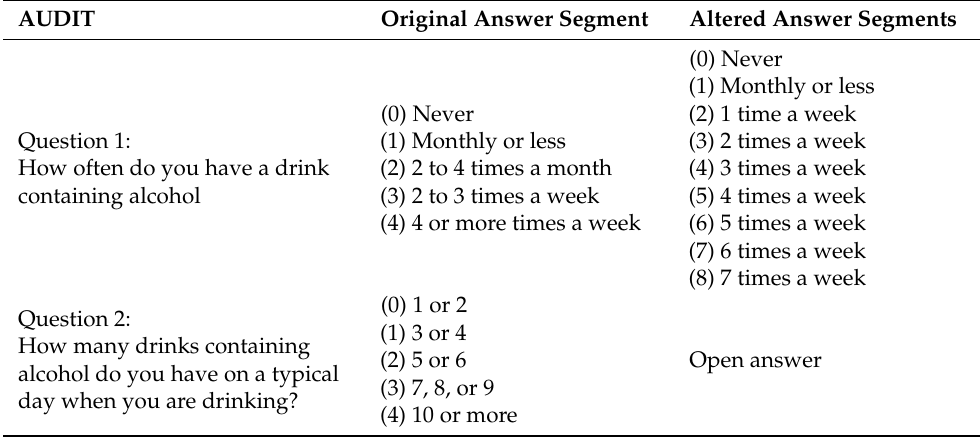
Table A1. The original and altered answer segments of question 1 and question 2 of the